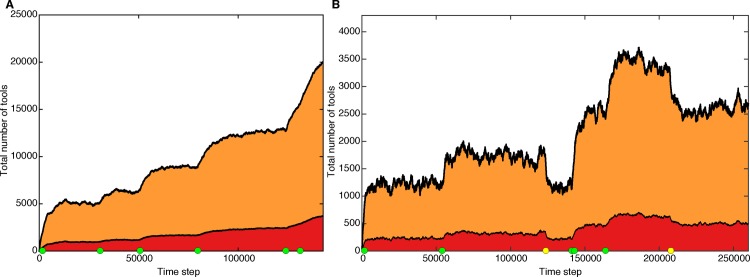
Cultural accumulation when innovations can increase and decrease the rate of culture loss.Red indicates lucky leap innovations and orange indicates toolkit innovations. A green dot indicates the occurrence of a rare innovation that decreases the rate at which culture is lost. The cultural trajectories in panels A and B differ in that panel B allows those loss-reducing innovations to be themselves lost, thus effectively increasing the rate of cultural loss. Losses of these innovations are indicated by yellow dots. Note that the y-axes on panels A and B differ greatly. Panel A parameters: N = 80, Plucky = 0.04, Ptoolkit = 0.2, Pcombination = 0, PspontLoss (initial) = 0.04, PLossRateReduction = 0.00002, Preverse = 0, Lmax = 11. Panel B parameters: N = 40, Plucky = 0.04, Ptoolkit = 0.2, Pcombine = 0, PspontLoss (initial) = 0.04, PLossRateReduction = 0.000007, Preverse = 0.000004, Lmax = 11.